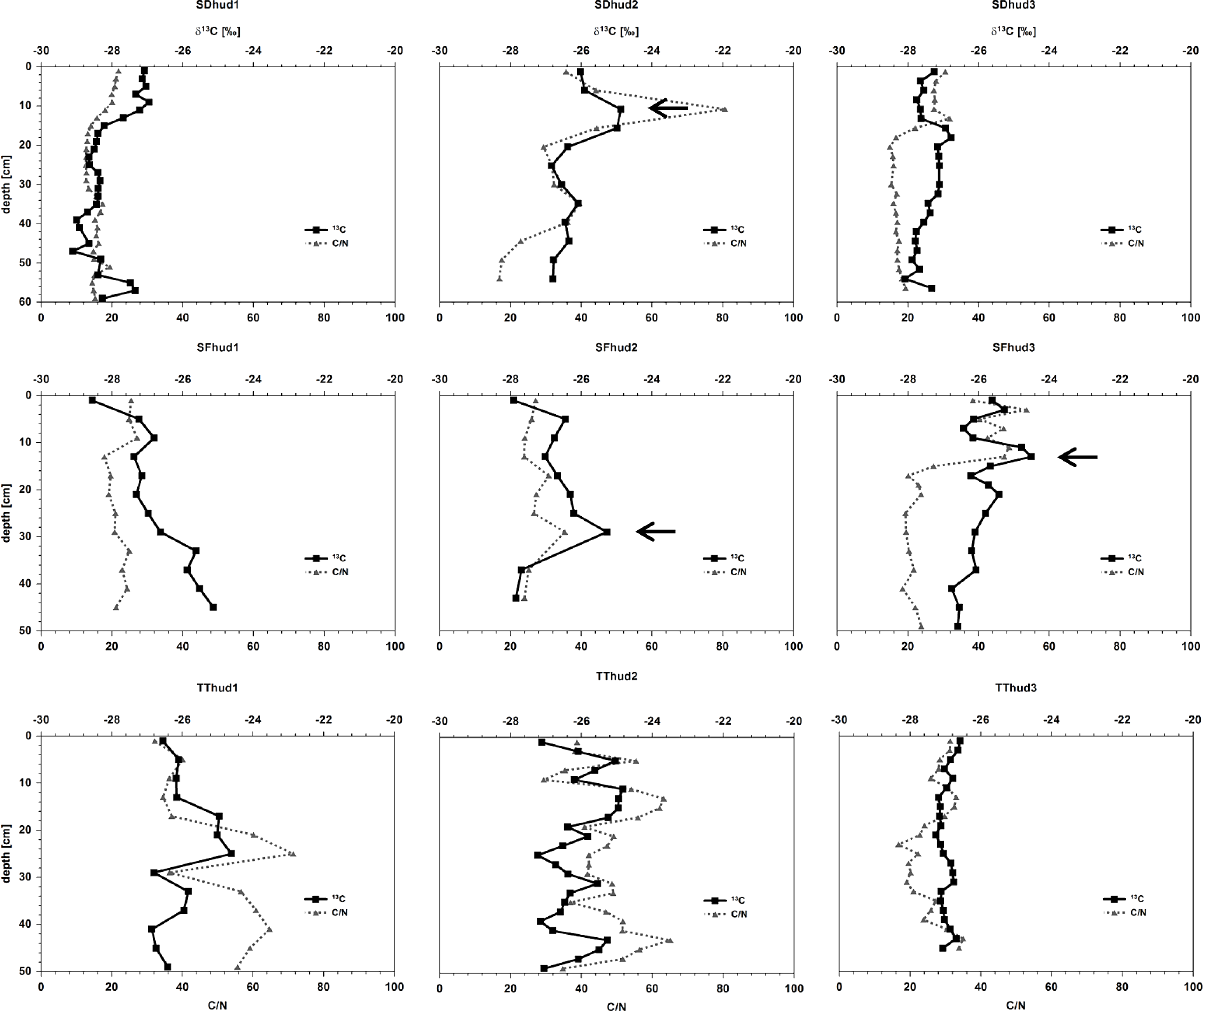
Figure 4. δ 13 C and C/N ratio in depth profiles of degraded hummocks (hud) at Stordalen (SD), Storflaket (SF) and Torneträsk (TT) peatland. Turning points in the profiles are indicated with black